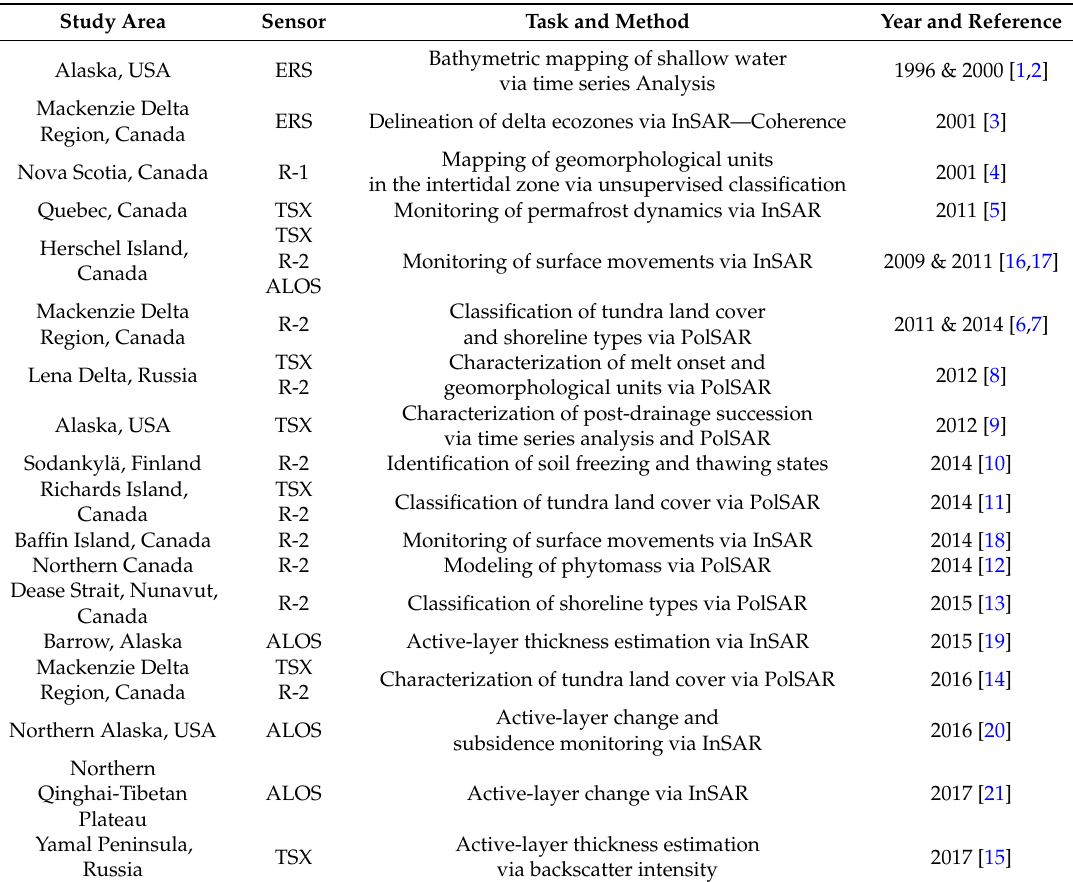
Table 1. Select studies that employed Synthetic Aperture Radar (SAR), polarimetric SAR (PolSAR) and InSAR (SAR interferometry) data and methods for the characterization of tundra (permafrost) landscapes and their dynamics; ERS: European Remote Sensing Satellite; R-1: Radarsat-1; TSX: TerraSAR-X; R-2: Radarsat-2; ALOS: Advanced Land Observing